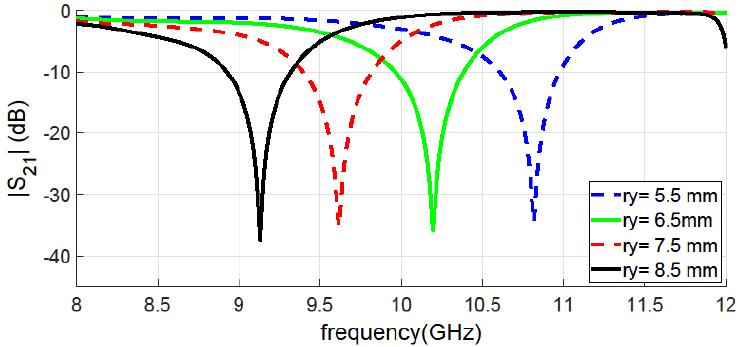
Figure 6. Simulated Ez field component for the 1 cell resonator (rx = 4.8 mm, ry = 6.5 mm gx = 0.2 mm and r = 0.8 mm) response at frequency ( a ) f = 10.45 GHz ( b ) f = 11 GHz. Figure 7. Simulated resonator, with via in the lateral position, transmission response for different length (ry) in mm (rx = 5 mm, gx = 0.2, r = 0.7 mm, d = 0.3 mm).